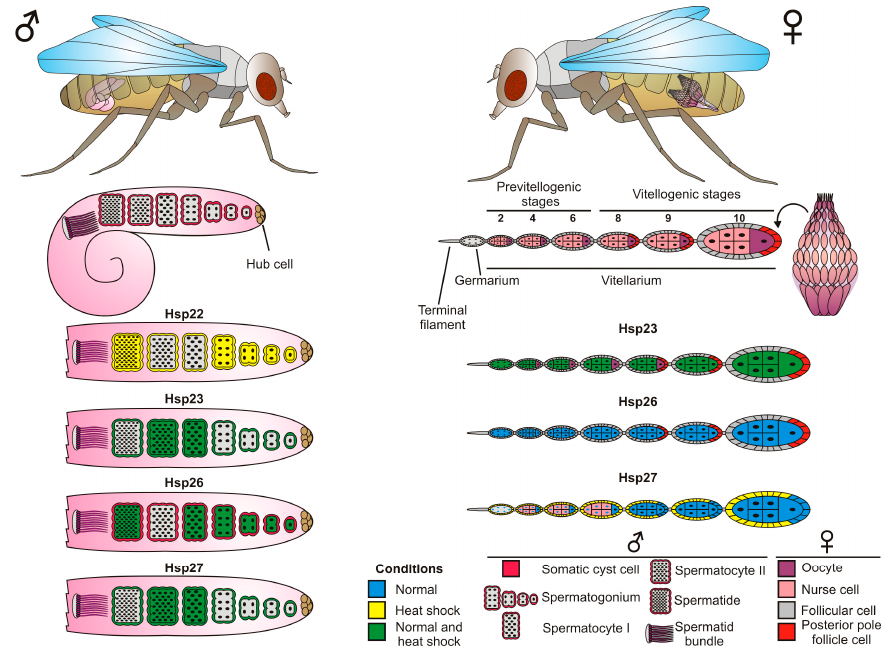
Figure 4. Developmentally regulated and heat shock-induced expression of Hsp22, Hsp23, Hsp26, and Hsp27 in male and female Drosophila germ line cells.